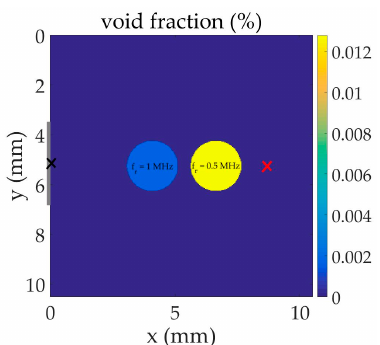
Figure 3. Schematic representation of the two-dimensional problem in which the black and red crosses represent the input and output signal positions, respectively.